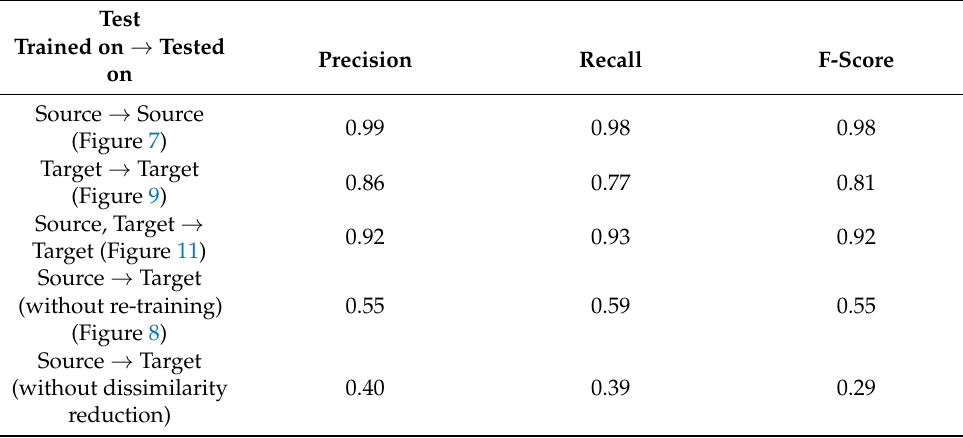
Table 3. Comparison of classification metrics for the different tests